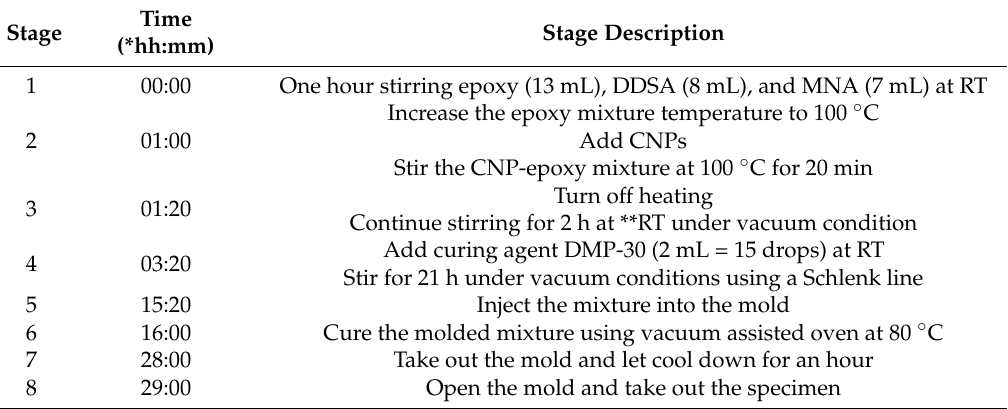
Table 1. Carbon nanoparticles (CNP) embedment